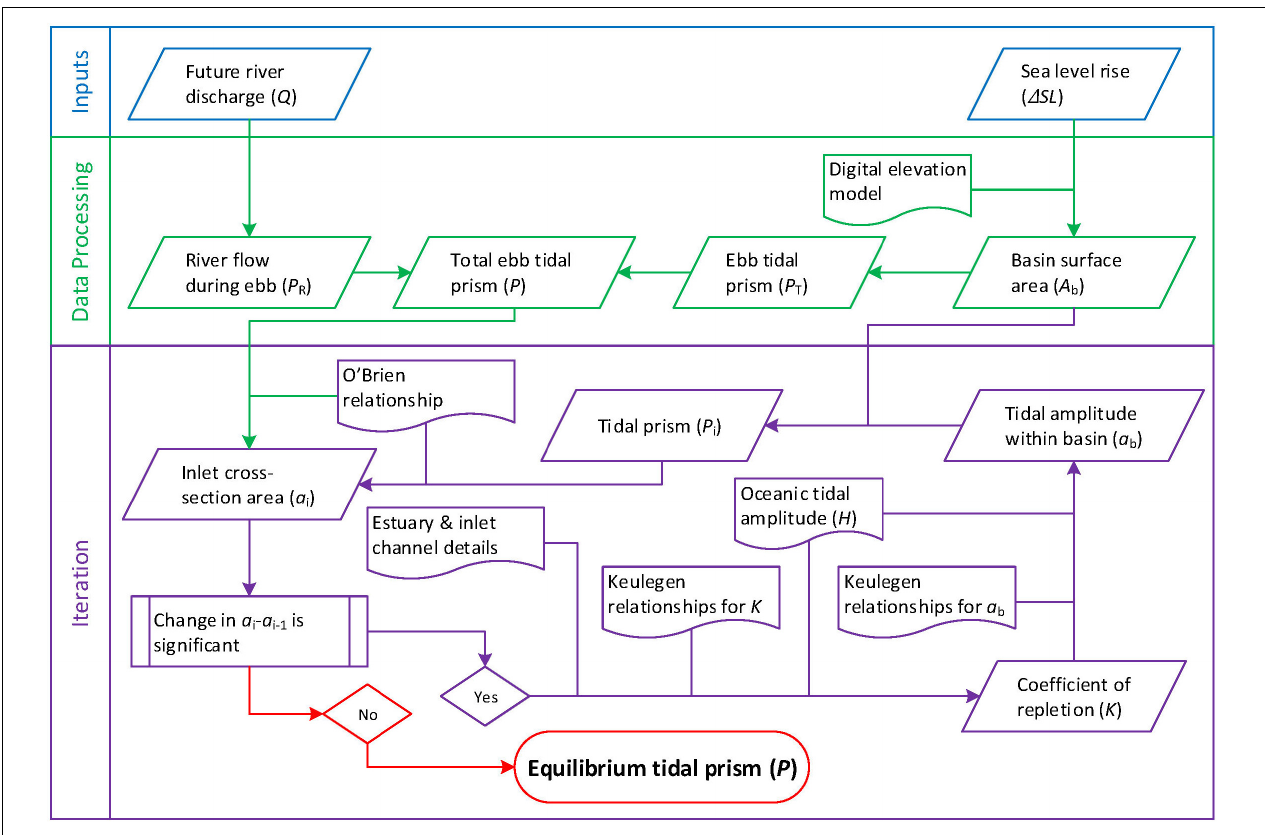
FIGURE 3 | Flowchart of the iteration procedure to determine equilibrium tidal prism at estuaries with low-lying margins (modified from Bamunawala et al.,